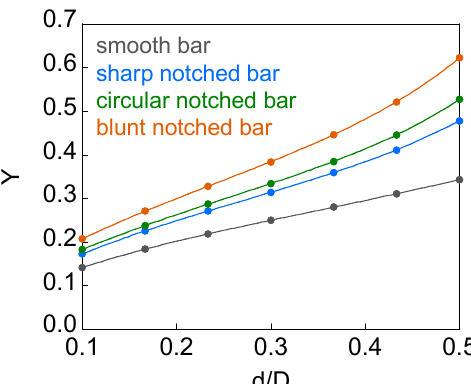
Figure 6. Dimensionless SIF vs. relative crack diameter for smooth and notched bars with non-eccentric circular inner cracks (symmetrical case).